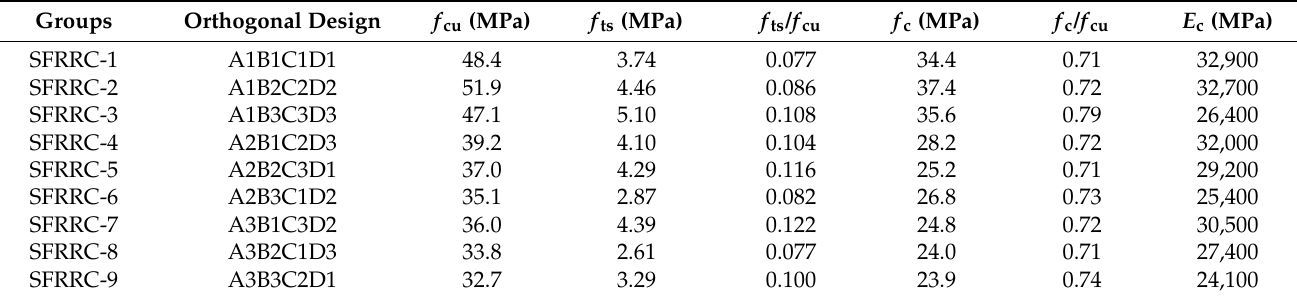
Table 6. Test results of mechanical properties.